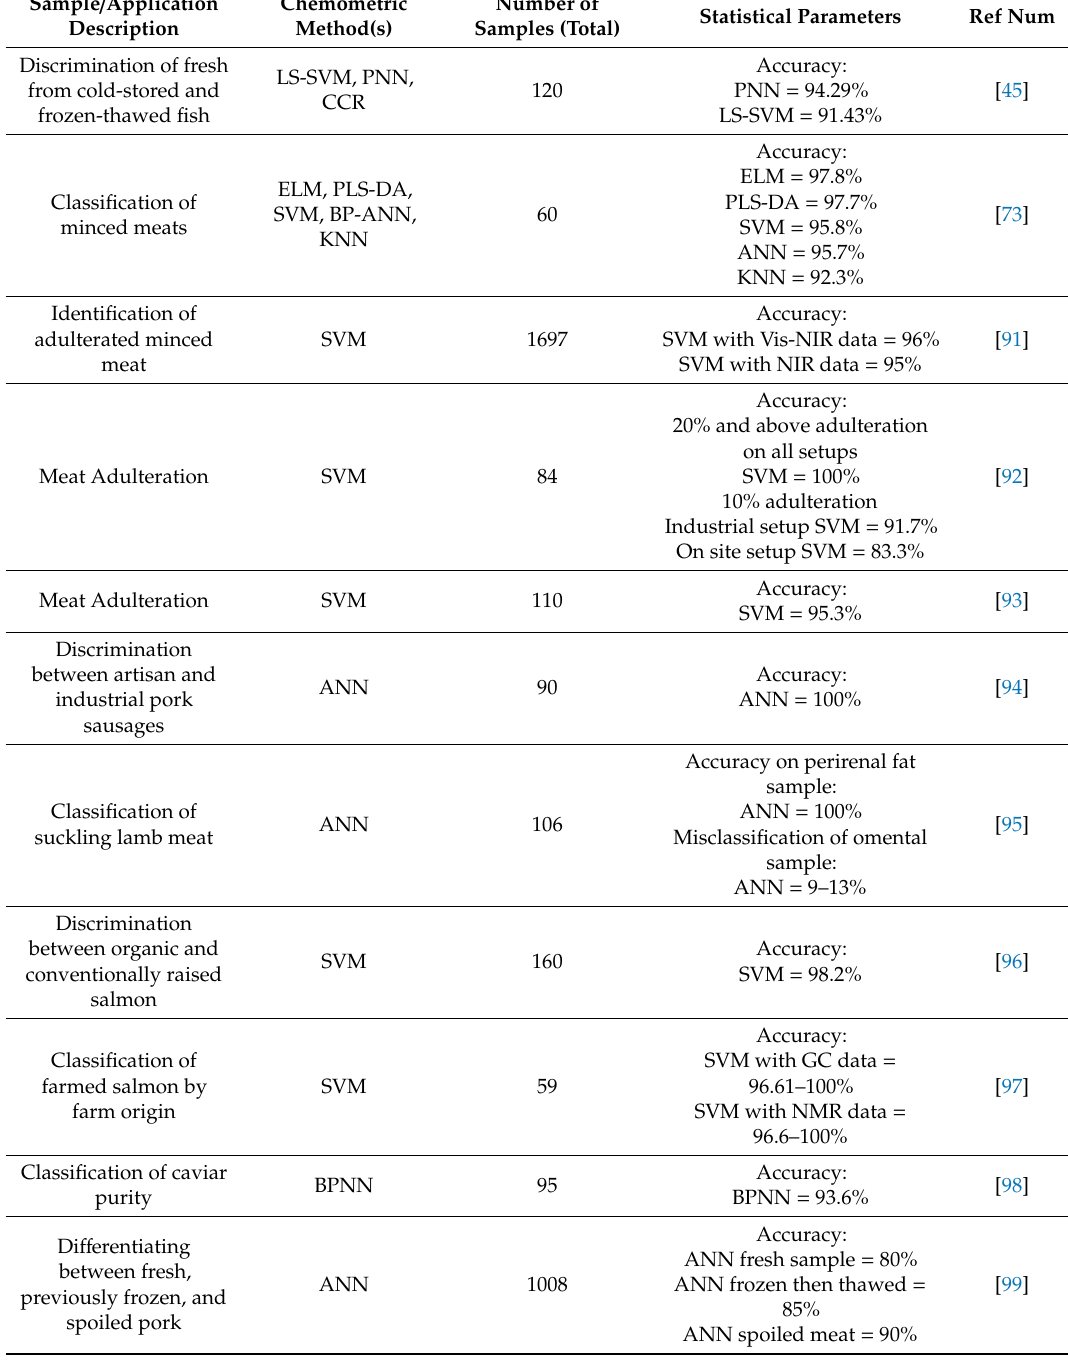
Table 4. Literature related to the use of chemometrics in classification of